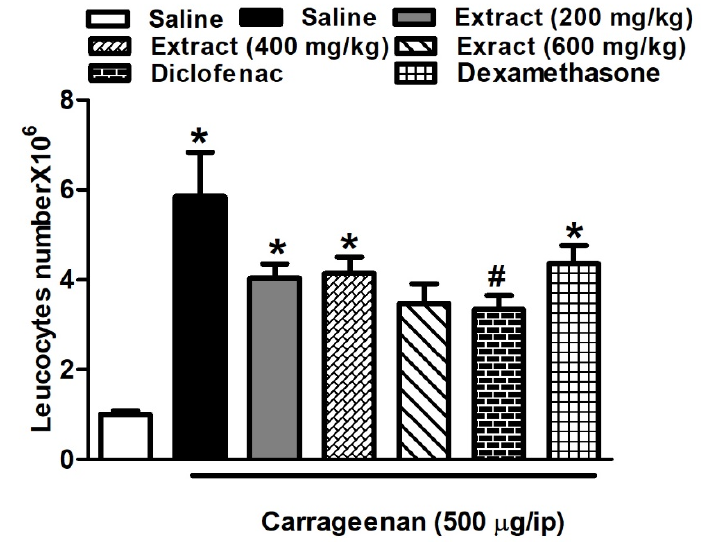
Figure 3. Carrageenan effect on leukocyte migration to the peritoneal cavity of mice (total number × 10 6 ), with and without 1 h earlier treatment with H. campechianum flower extract in three different doses (p.o., 200, 400 and 600 mg/kg), diclofenac (p.o., 20 mg/kg) and dexamethasone (p.o., 2 mg/kg). Data are presented as mean values ± S.E.M (n = 5–7). * p < 0.05 vs. saline values, # p < 0.05 vs. control (carrageenan-treated